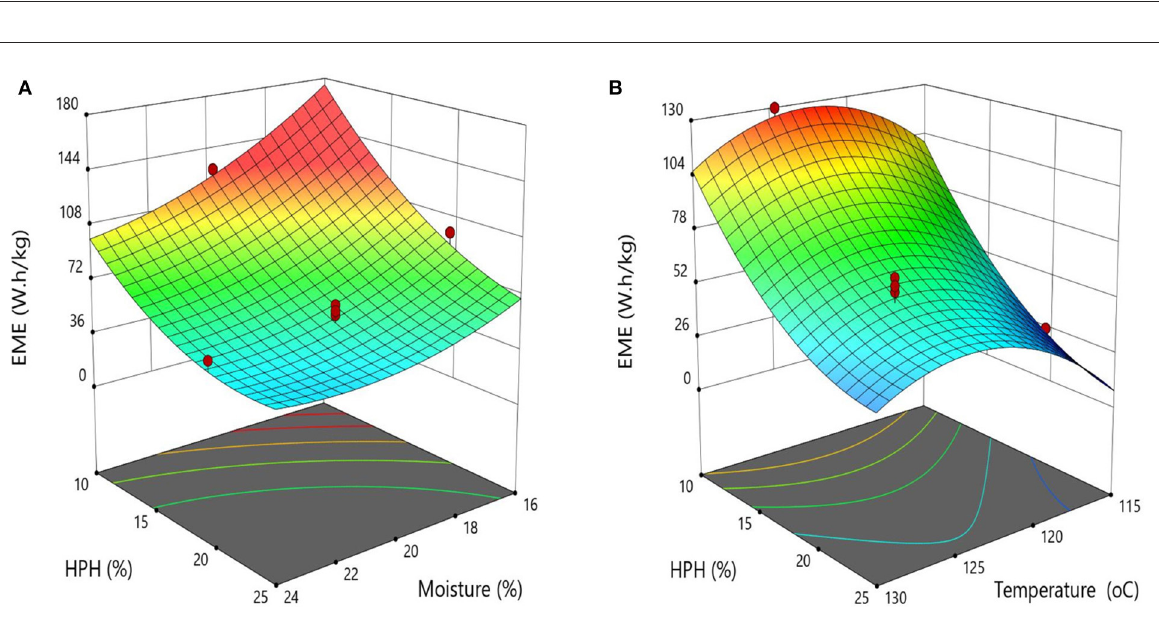
FIGURE2 Effect of HPH, moisture and screw speed on TMR. (A) Moisture vs. HPH (temperature 125 ◦ C and screw speed 220 RPM). (B) Screw speed vs. HPH (moisture 20% and temperature 125 ◦